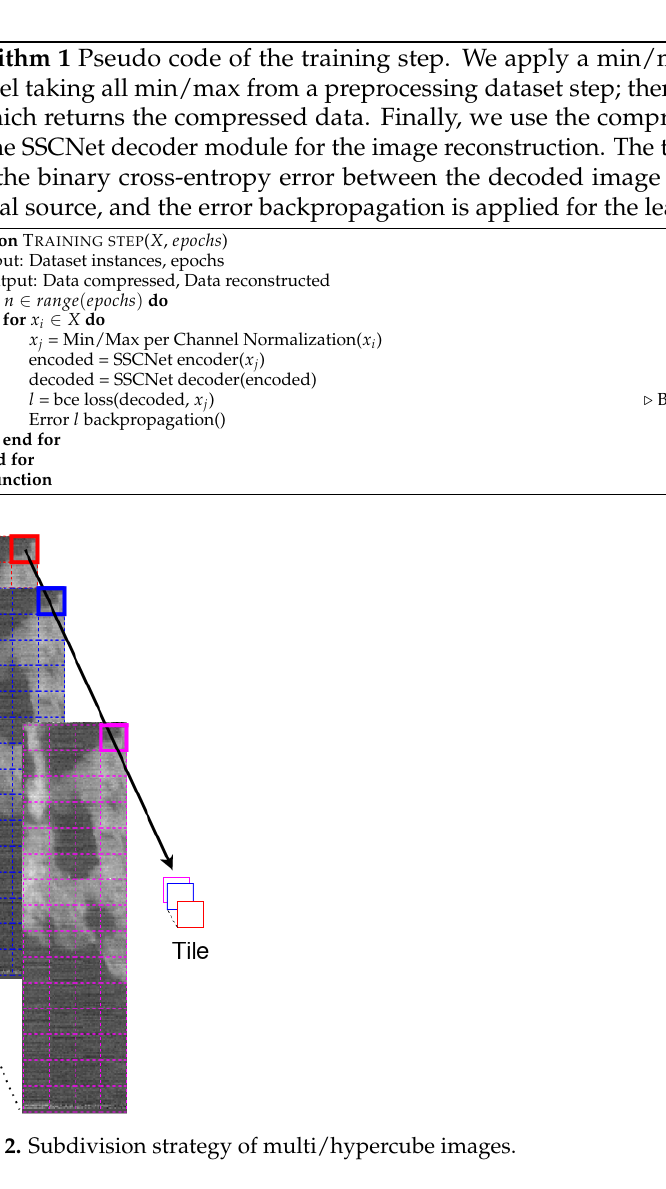
Algorithm 1 Pseudo code of the training step. We apply a min/max normalization per